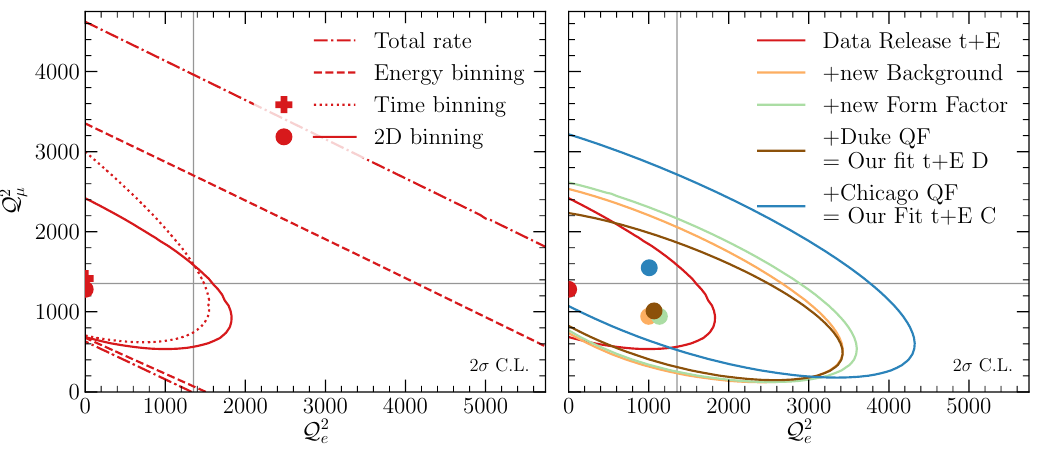
Figure 6 . 2 (cid:27) allowed regions for the (cid:13)avor-dependent weak charges for a variety of (cid:12)ts to COHERENT data as labeled in the (cid:12)gure. In all cases shown in the left panel, the QF, nuclear FF and background assumptions are those employed in the data release [36]. On the right panel we show the dependence on the steady background modeling, nuclear FF, and QF. The vertical lines 2 2 indicate the SM value = = 1353 : 5. The colored dots and the red cross mark the position of e (cid:22) Q Q the best-(cid:12)t for the various